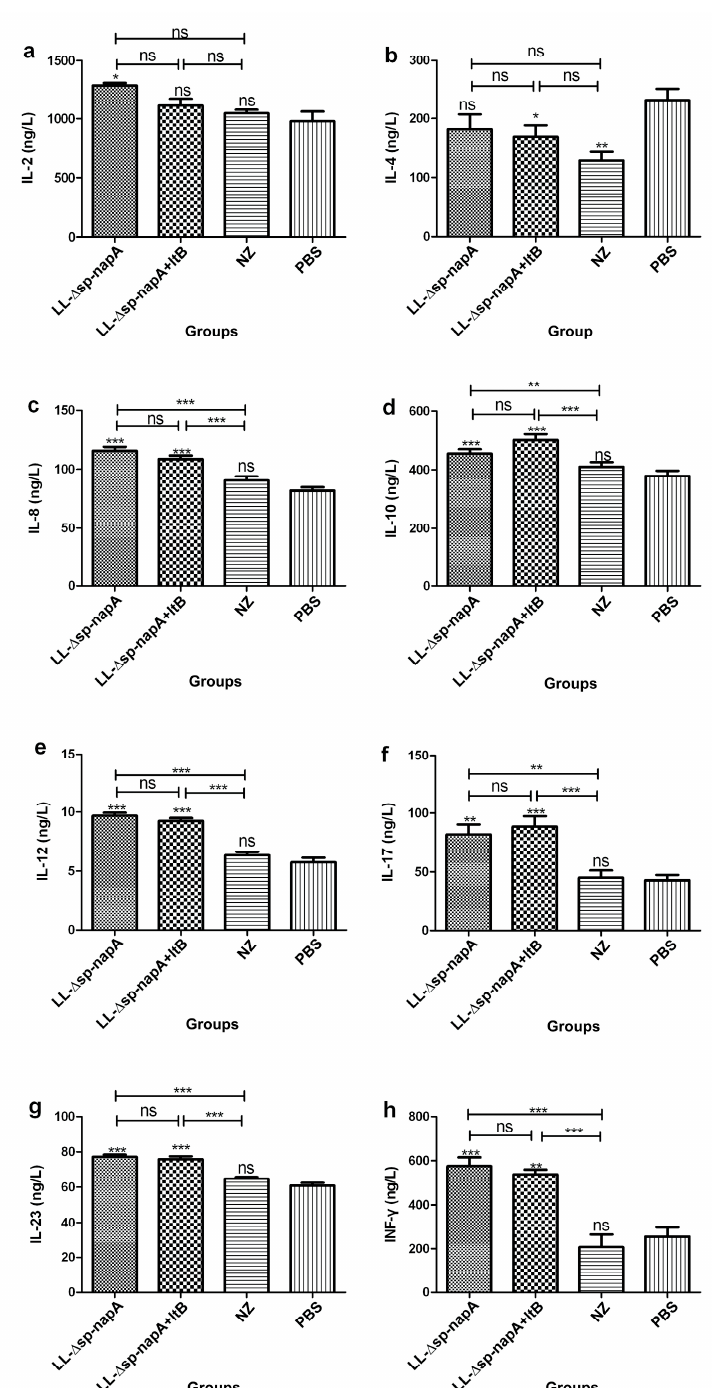
Figure 4. Cytokine expression levels of in vitro cultivated splenocytes ( a – h ). Splenocytes were separated from the mice one weeks post immunization, and cultivated and stimulated with H. pylori cellular lysates for 3 days. The cytokines in the culture supernatant was measured using ELISA with three replicates. Data were expressed as mean ± SEM. Error bars indicate standard deviations. NZ- ∆ sp-napA , NZ- ∆ sp-napA + ltB , NZ and PBS groups, n = 6 each group; ns: no significance, p ≥ 0.05; * , ** , *** : p < 0.05, p < 0.01, p < 0.001, respectively, compared with the PBS or designated group.